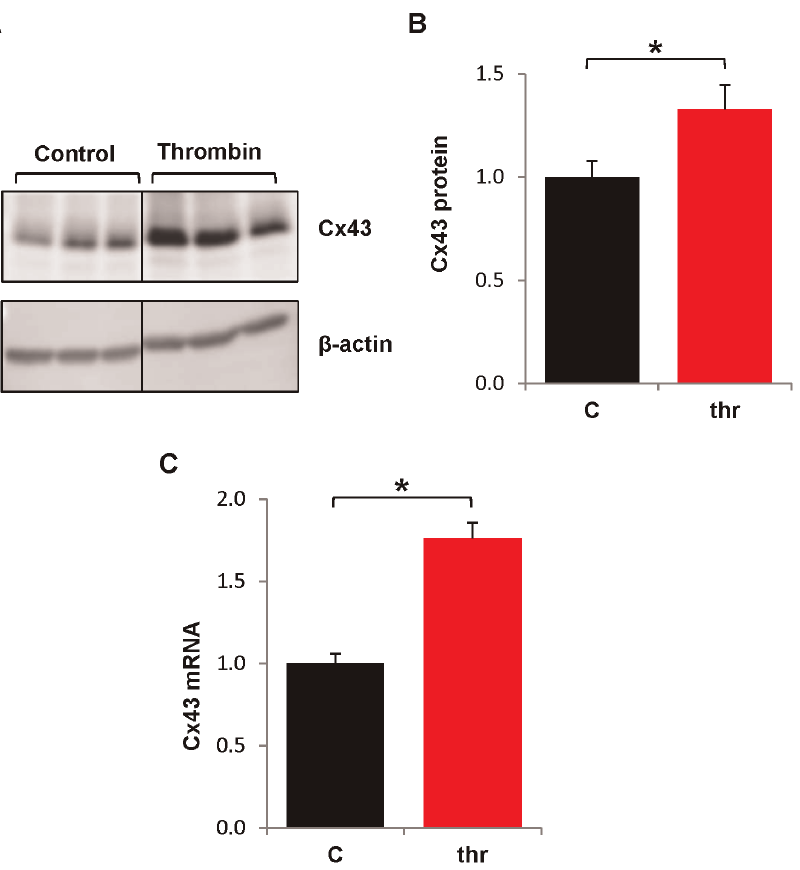
Figure 1. Chronic thrombin treatment increases Cx43 protein expression. HPAECs were left untreated or treated hourly with thrombin (0.5 U/mL) over 6 hr. and Cx43 protein and mRNA were measured. A.) Representative immunoblot shows Cx43 protein levels in thrombin (thr) or control (C) HPAECs. Panel images for control and thrombin bands were recombined from images generated from a single membrane of a Western blot. B.) Graph shows densitometric analysis of Cx43 protein expression. Cx43 protein levels were normalized to b -actin levels and divided by the average control value. *, p , 0.05, n=9. C.) Cx43 mRNA levels were measured by real-time RT-PCR and normalized to GAPDH mRNA and divided by the average control value. *p , 0.05,